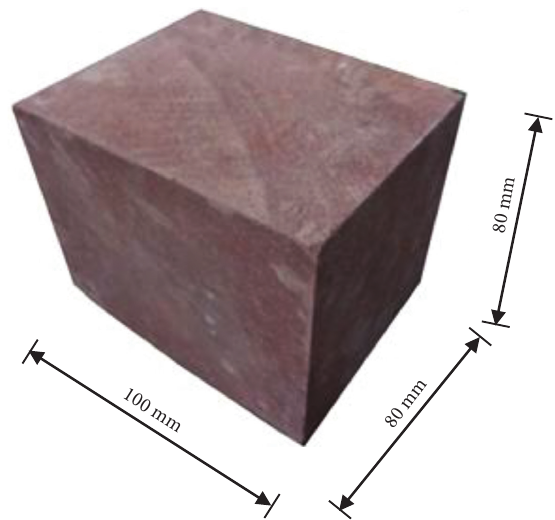
Figure 1: The size of mudstone specimen. Table 1: The physical and mechanical properties of mudstone.